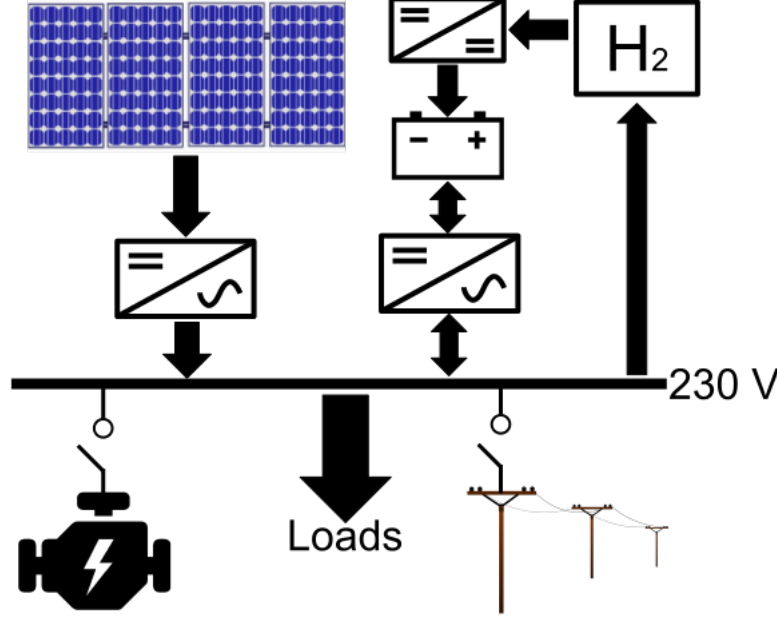
Figure 1. Basic overview of the nanogrid energy Figure 1 . Basic overview of the nanogrid energy system.